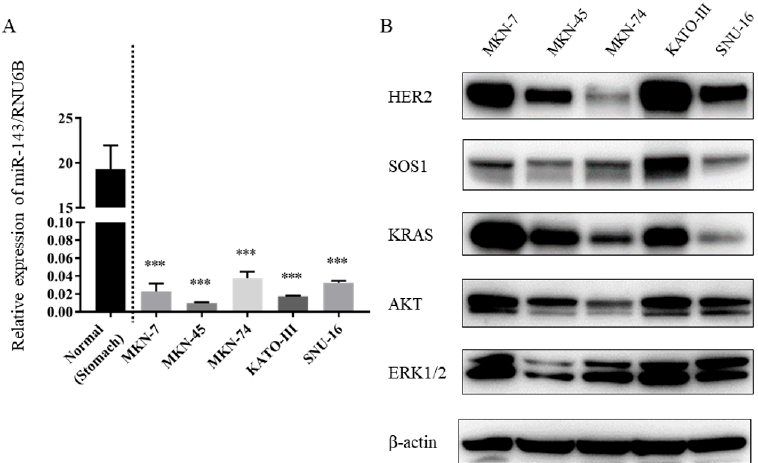
Figure 1. Down-regulation of miR-143 in gastric cancer cell lines, and up-regulation of HER2, KRAS, and KRAS-related molecules in HER2-positive gastric cancer cell lines MKN-7 and KATO-III. ( A ) Relative expression level of miR-143 in gastric cancer cell lines. ( B ) HER2-positive gastric cancer cell lines MKN-7 and KATO-III showed up-regulated KRAS and its effector signaling proteins ATK and ERK compared with their levels in other gastric cancer cell lines. In addition, the protein expression levels of key molecules of the KRAS networks were up-regulated in MKN-7 and KATO-III cells. Results are presented with the mean ± SD; *** p <